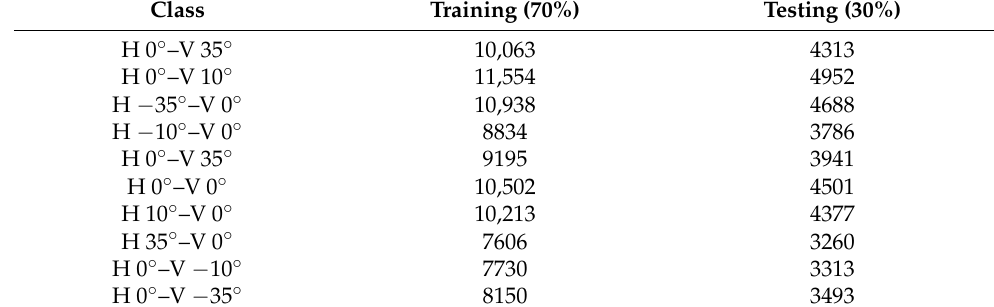
Table 2. Custom eye gaze estimation dataset details.